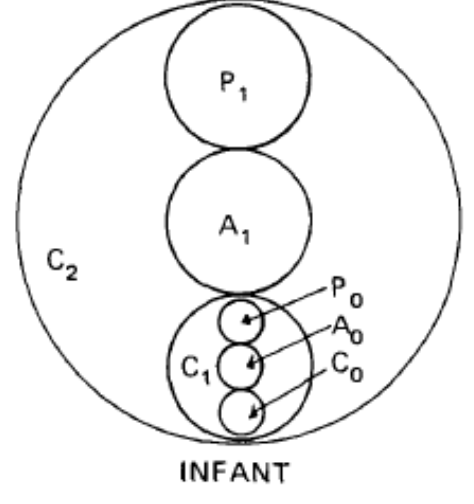
Figure 1: Development of the Child Ego State (Schiff, 1977,